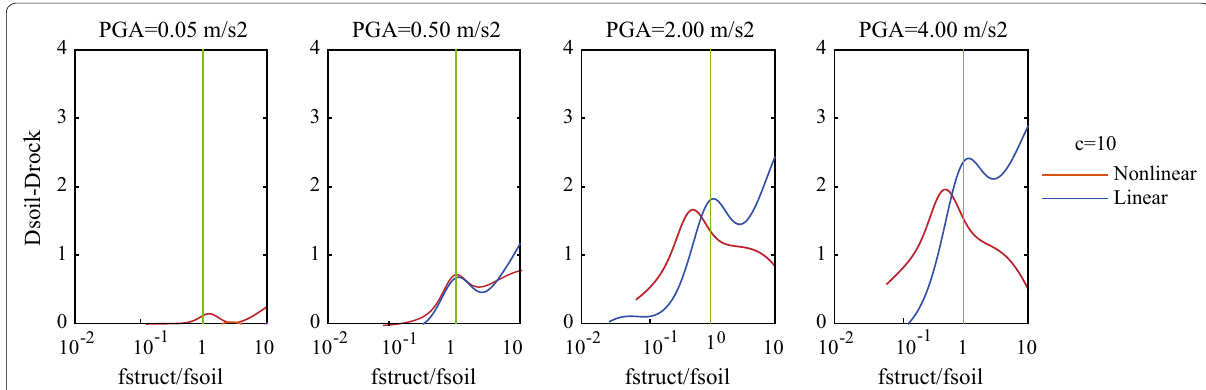
Fig. 9 Comparison of the variation of predicted rock‑to‑soil damage increment for class 3 buildings as a function of the structure‑to‑soil frequency ratio in the linear ( blue ) and nonlinear ( red ) cases, for four values of PGA and considering a velocity contrast c